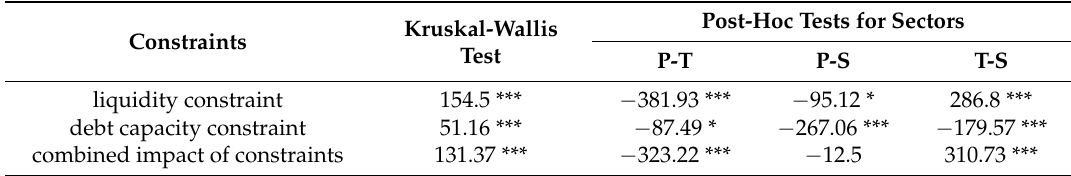
Table 4. Results of Kruskal–Wallis test for sectors and type of constraints.